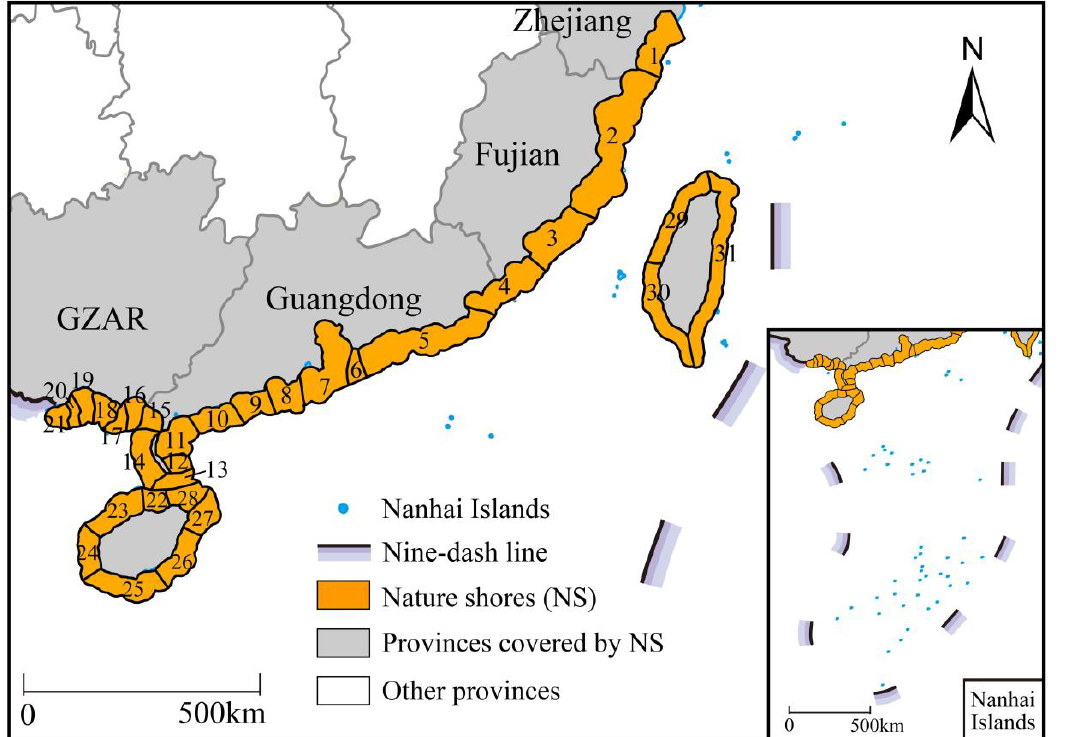
Figure 2. Distribution of the 31 natural shores